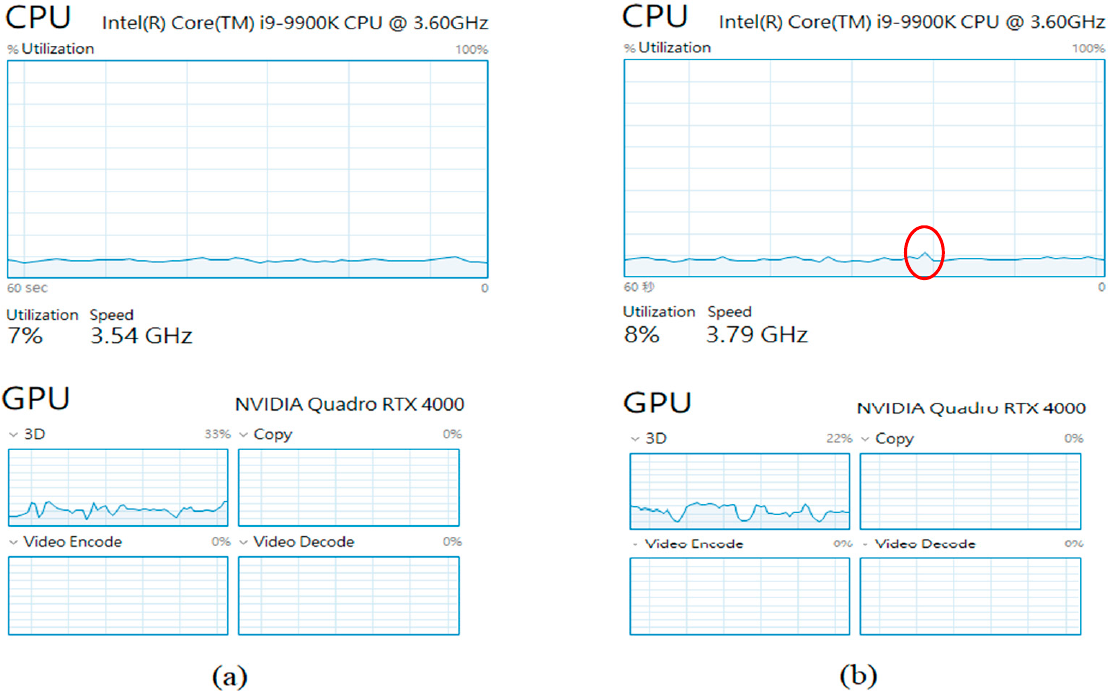
Figure 15. Utilization of CPU and GPU: seeking object with ( a ) map-based navigation–signage system and ( b ) cross-zone navigation–signage system.